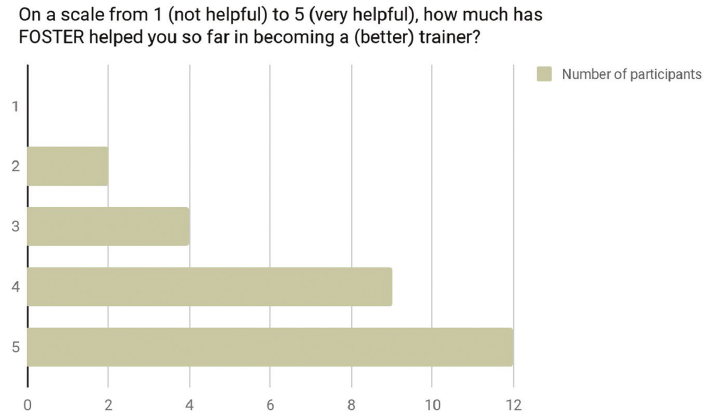
Fig. 2: Responses to bootcamp feedback